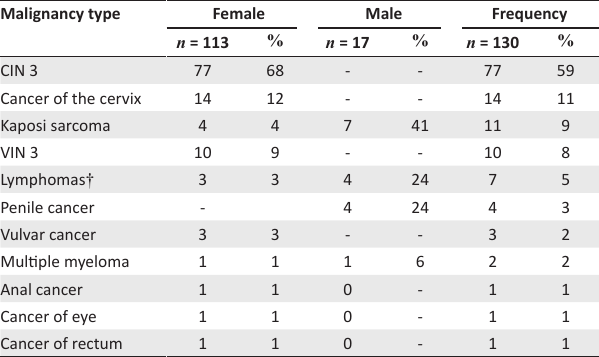
TABLE 3: Distribution of malignancies amongst elderly patients receiving antiretroviral therapy at Newlands Clinic in March 2020, by sex. Malignancy